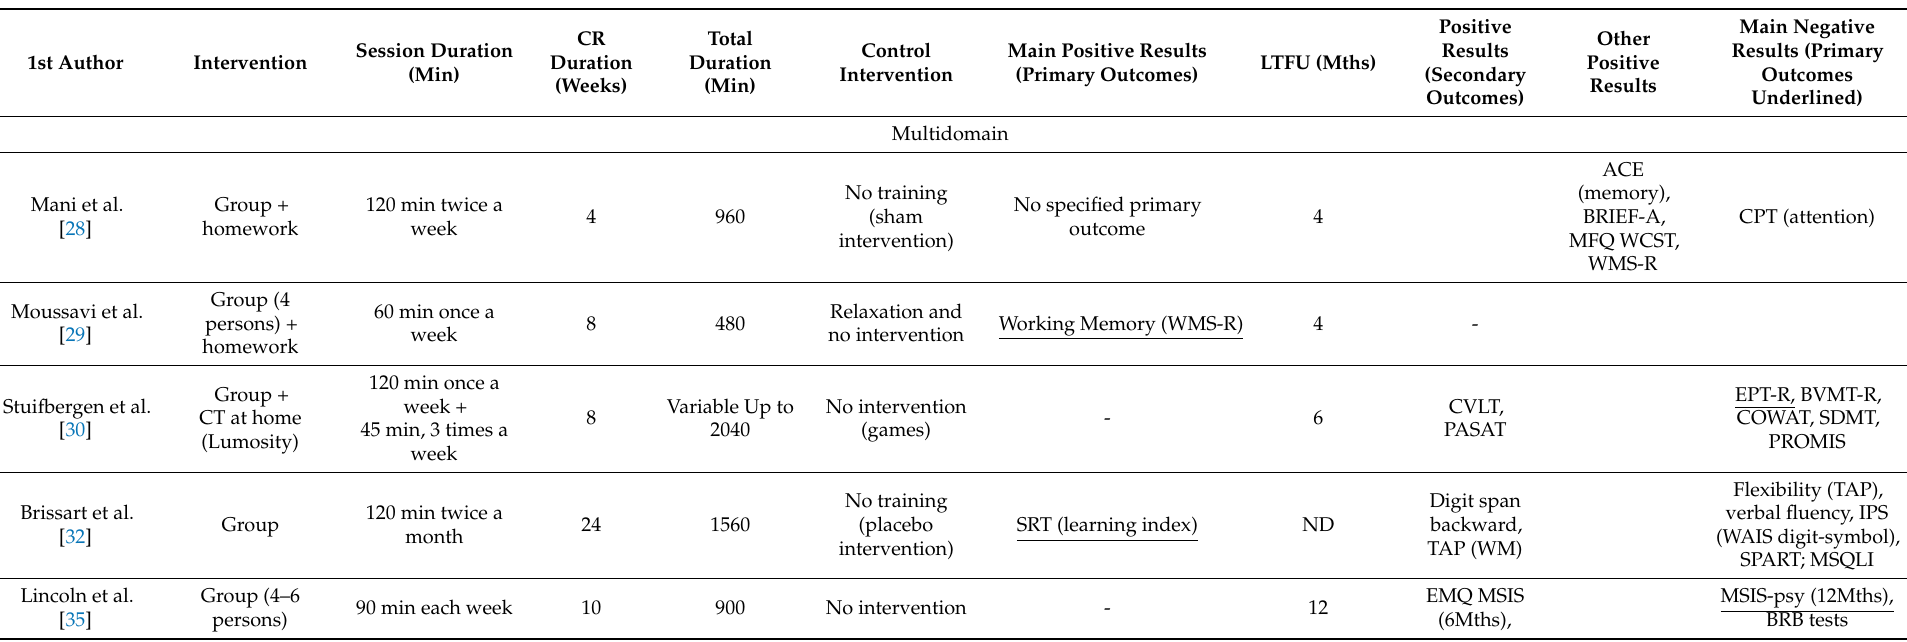
Table 4. Group Interventions blinded